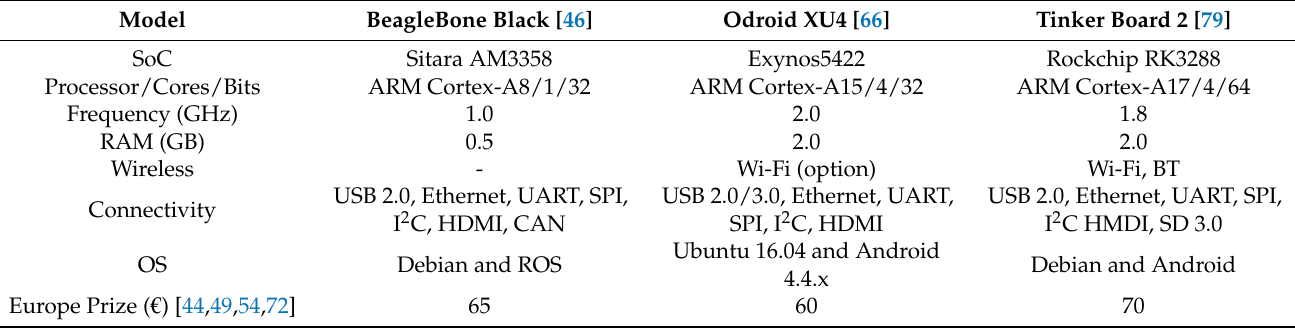
Table 4. Main open-source SBCs Linux based in the market.